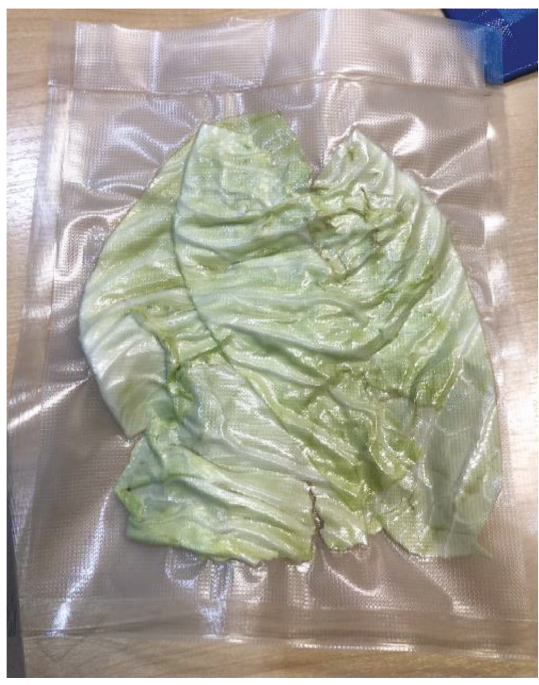
Figure 1: Cabbage leaves in a vacuum-sealed